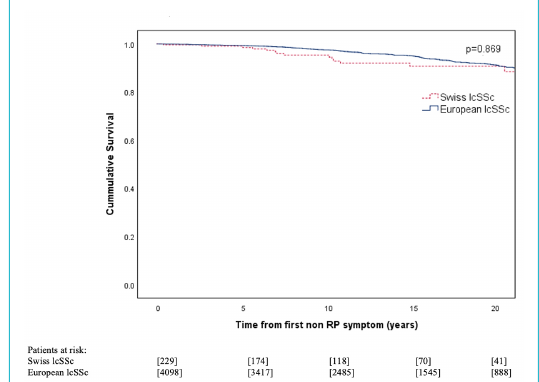
Figure 4: Kaplan-Meier survival analysis lcSSc patients. lcSSc = limited cutaneous systemic sclerosis; RP = Raynaud’s phenome-